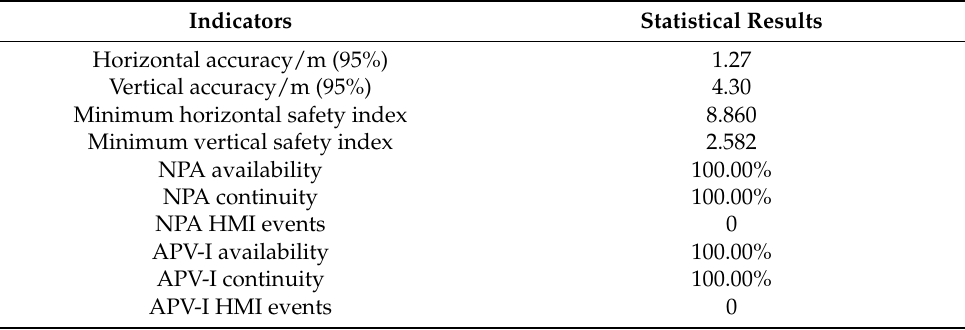
Table 3. BDSBAS SF performance statistics of flight test-II.